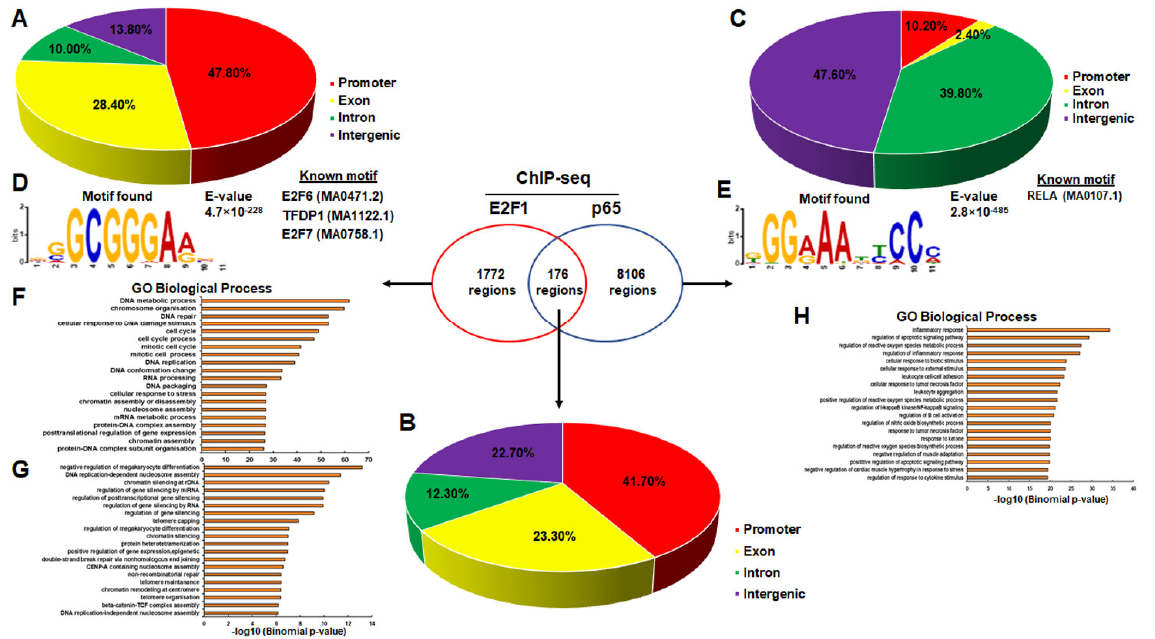
Figure 2. ( A – C ) The figure panels depict the genomic distribution of E2F1-specific, E2F1-p65 common, and p65-specific peaks respectively in HeLa cells. ( D , E ) The figure panels show the top motif for E2F1-specific and p65-specific peaks, respectively. ( F – H ) The figure panels illustrate the top biological processes for E2F1-specific, E2F1-p65 common, and p65-specific peaks, respectively. To identify whether p65 binds to chromatin that carries active chromatin marks even prior to stimulation, we re-analysed p300 ChIP-seq data prior and upon TNFα stimulation [51]. We found that the majority of E2F1-p65 common peaks (64%) and p65-specific peaks (59%) reside in chromatin that is bound by p300 prior and upon stimulation (Figure 3). Only a small proportion of the E2F1-p65 common peaks (18%) and p65-specific peaks (19%) are attracting p300 upon TNFα stimulation. Finally, 15% of the E2F1-p65 common peaks and 21% of the p65-specific peaks are without p300 both prior and upon TNFα stimulation. These highlight the preference of p65 and E2F1 to positively regulate their target genes.